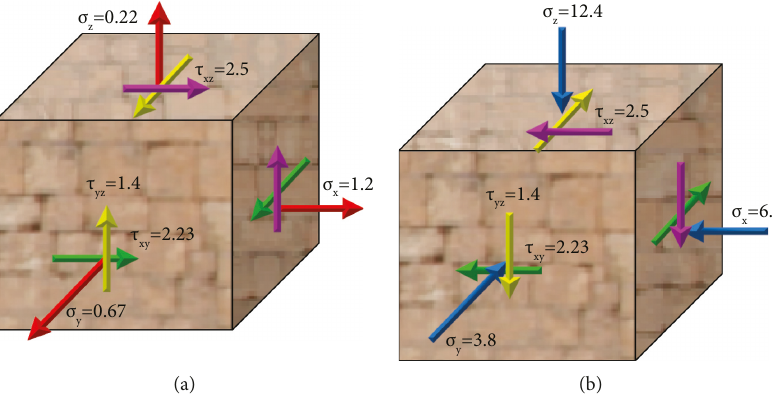
Figure 6: Tensor of the maximum and minimum